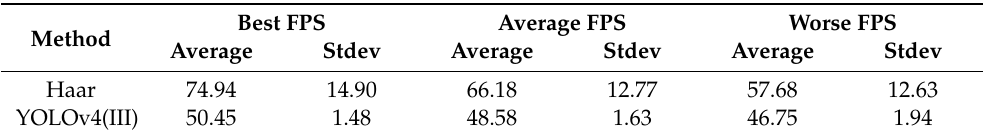
Table 7. Adding 5 other runs for